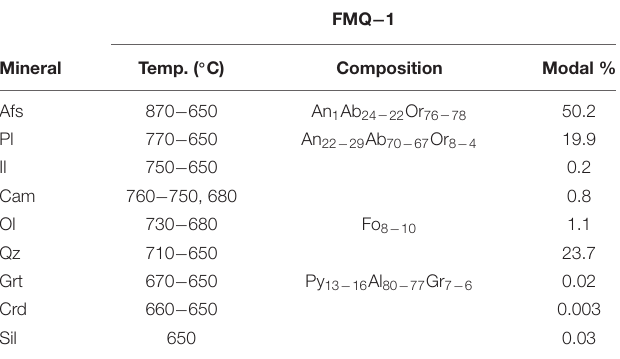
TABLE 3 | Summary of mineral fractionation and modes of the MELTS models.